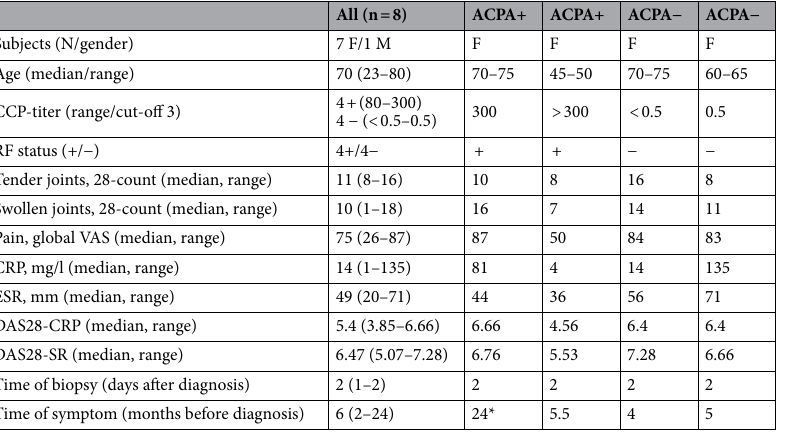
Table 1. Patient characteristics. *This patient had knee pain 24 months prior to fulfilling an RA diagnosis that was ascribed as early knee arthrosis based on X-ray (no any alterations in small joints were found at this time point). She subsequently developed small joint arthritis 1 month prior to RA